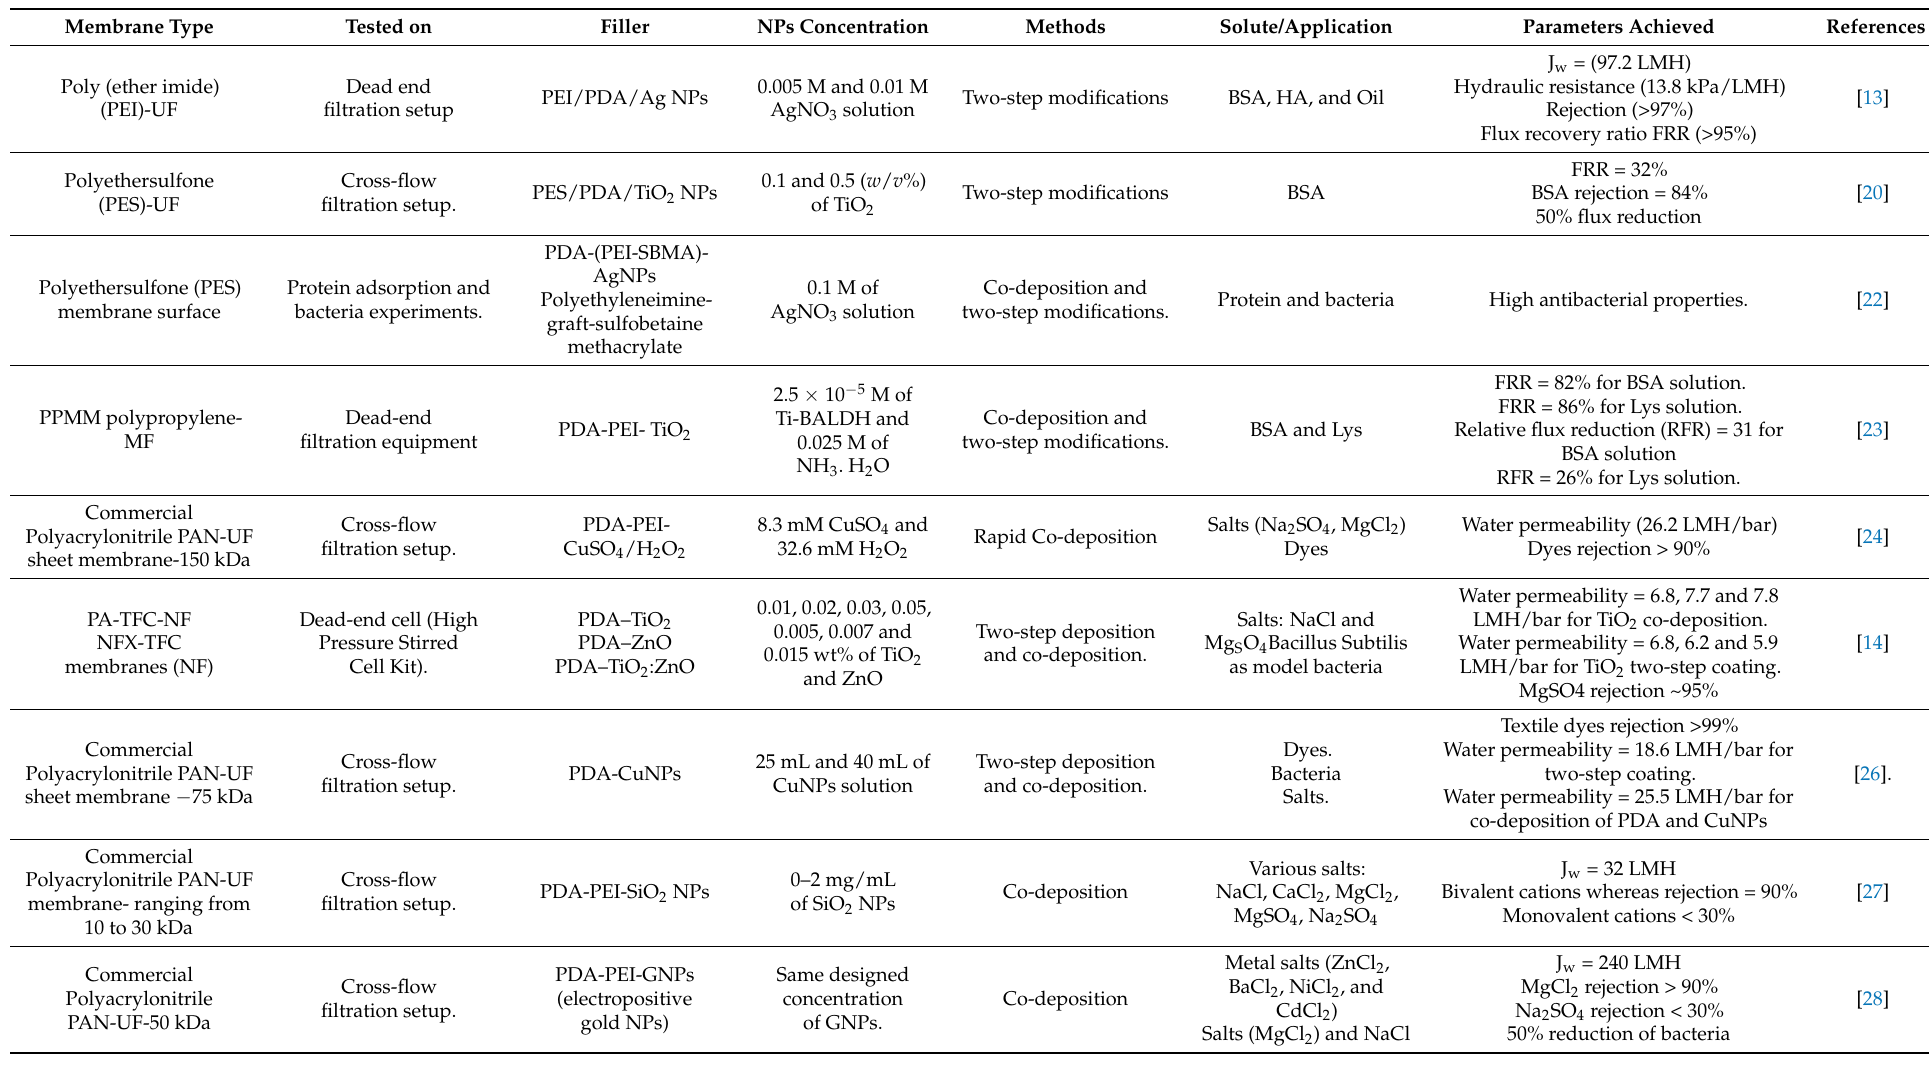
Table 1. Studies based on two-step and one-step modification methods for UF, NF, and MF